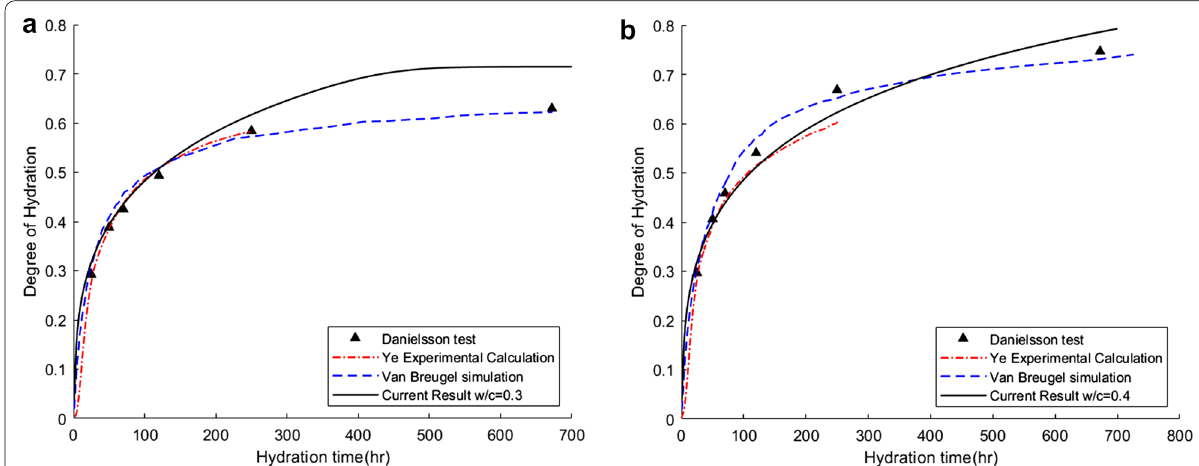
Fig. 4 Comparison of hydration simulation result with different test result ( a ) w/c